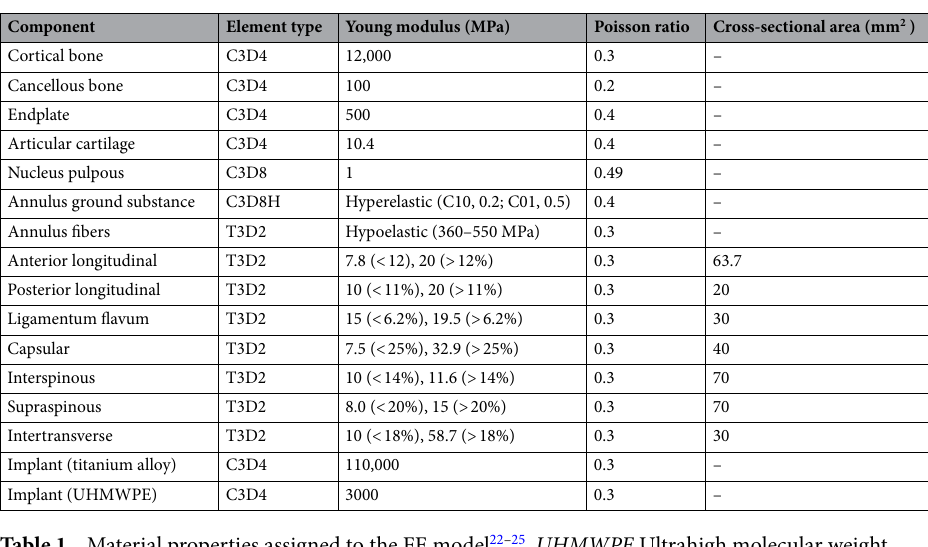
Table 1. Material properties assigned to the FE model 22–25 . UHMWPE Ultrahigh molecular weight polyethylene.